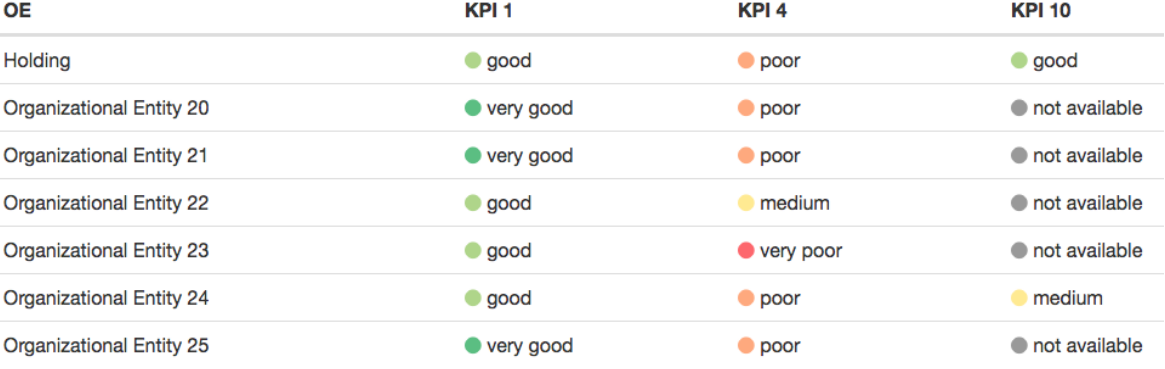
Figure 8. Tabular visualization of OEs